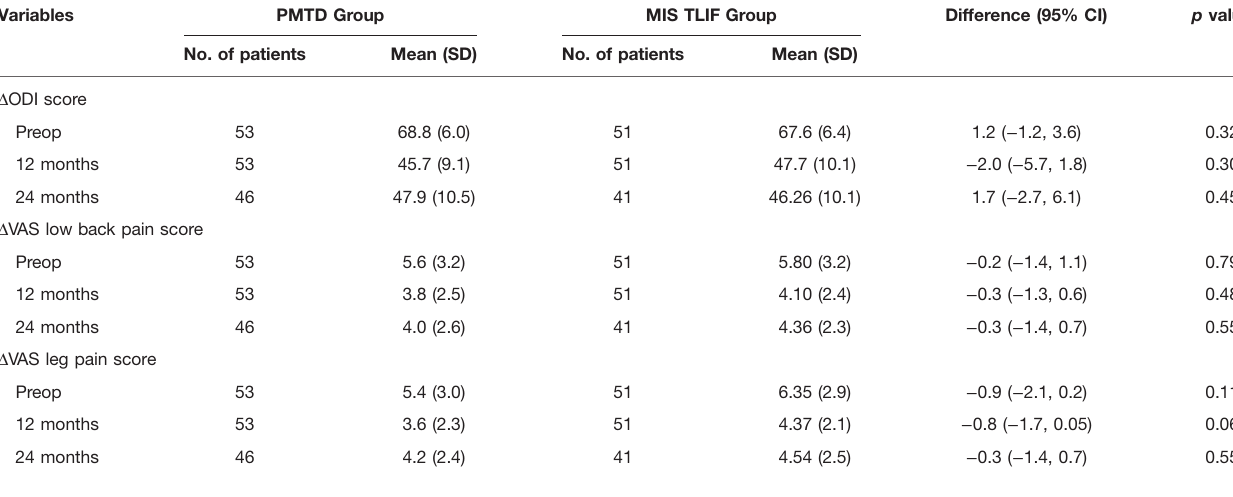
TABLE 3 | Changes in ODI score and VAS score from